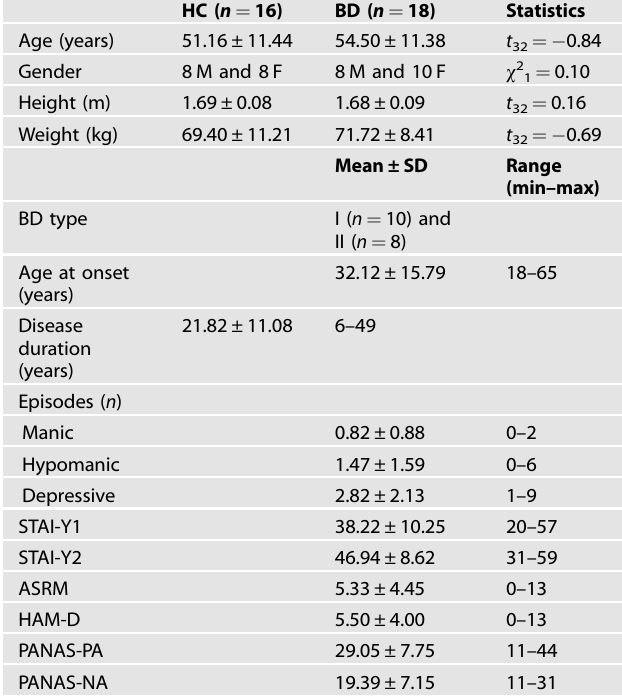
Table 1. Demographic, anamnestic, and clinical